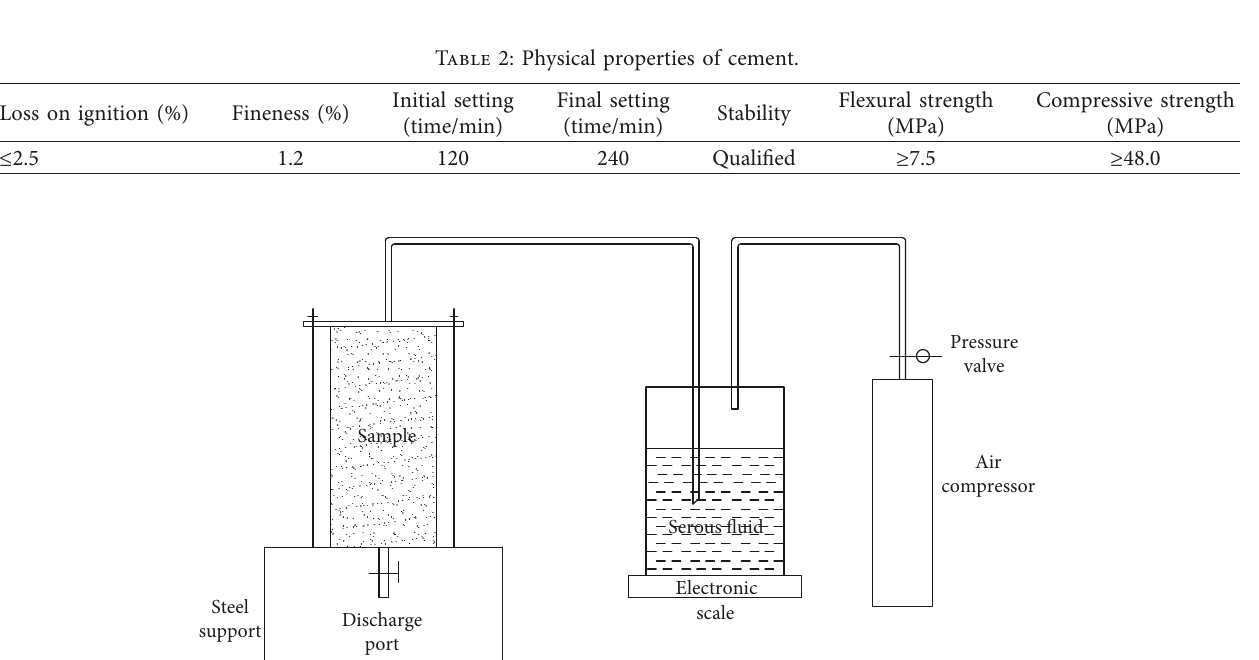
Figure 1: Schematic diagram of the test device.